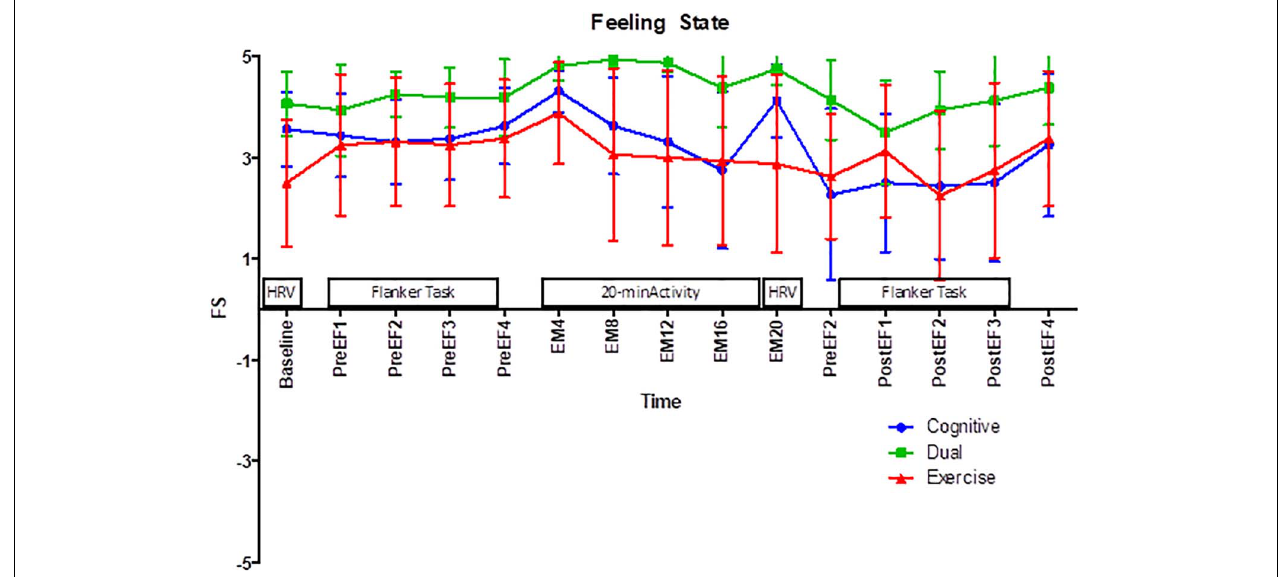
FIGURE 2 | Repeated assessment of feeling state across the study protocol. EF, executive function; EM, experimental manipulation; HRV, heart rate variability